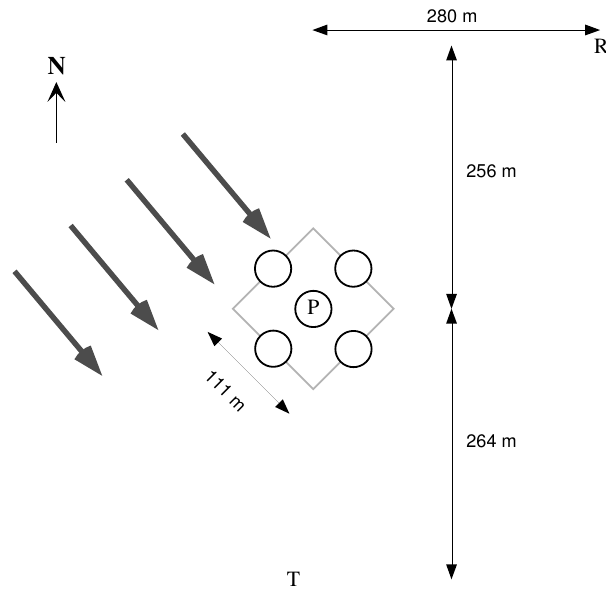
Fig. 2. Schematic layout of the relative locations of the instru- mented tower (T), the 1.3-GHz profiler (P), and the radiosonde shed (R) in relation to the gravity current. The footprint of the 10 ◦ verti- cal profiler beam at 200m is shown to scale as a circle around the P; circular approximations of the footprint and location of the oblique beams at 200m are indicated by circles to the NE, SE, SW, and NW of the vertical beam and are overlaid on a grey square outline for ease of viewing. Thick grey arrows show the approximate direc- tion (320 ◦ ) from which the gravity current arrived on 30 December